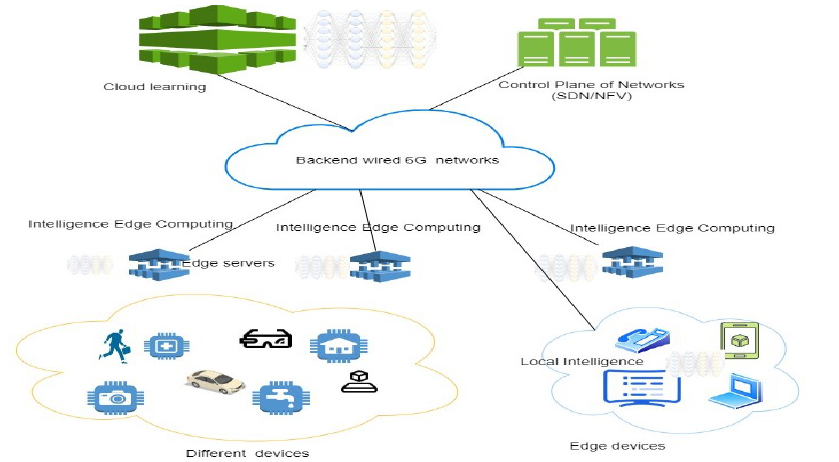
Figure 3. IEC and 6G